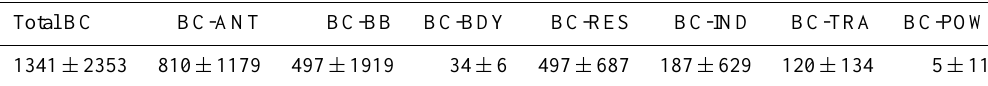
Table 4. Average ± standard deviation in mass concentration (ngm − 3 ) of total BC, BC from anthropogenic sources (BC-ANT), from biomass burning (BC-BB), from model domain boundaries (BC-BDY) and from residential (BC-RES), industrial (BC-IND), transportation (BC-TRA) and power generation (BC-POW) emissions averaged over South Asia (60–100 ◦ E, 5–37 ◦ N) during the ICARB period (18 March–11 May). The standard deviation was calculated from all the BC values in South Asia and thus represents the spatial variability of modeled average BC values in South Asia. Total BC BC-ANT BC-BB BC-BDY BC-RES BC-IND BC-TRA BC-POW 1341 ± 2353 810 ± 1179 497 ± 1919 34 ± 6 497 ±